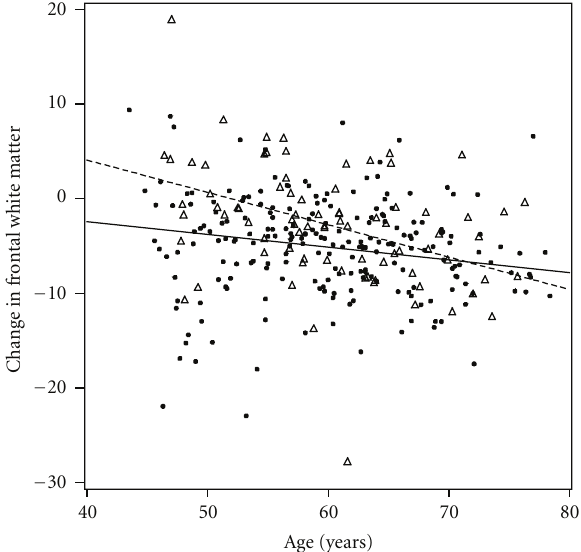
Figure 2: E ff ect modification by APOE genotype on relation of age with change in frontal WM volume for APOE ε 3/ ε 3 (black dots, solid regression line) and ε 3/ ε 4 plus ε 4/ ε 4 groups (triangles, dashed regression line). The slopes of the two lines were di ff erent ( P < 0.05).